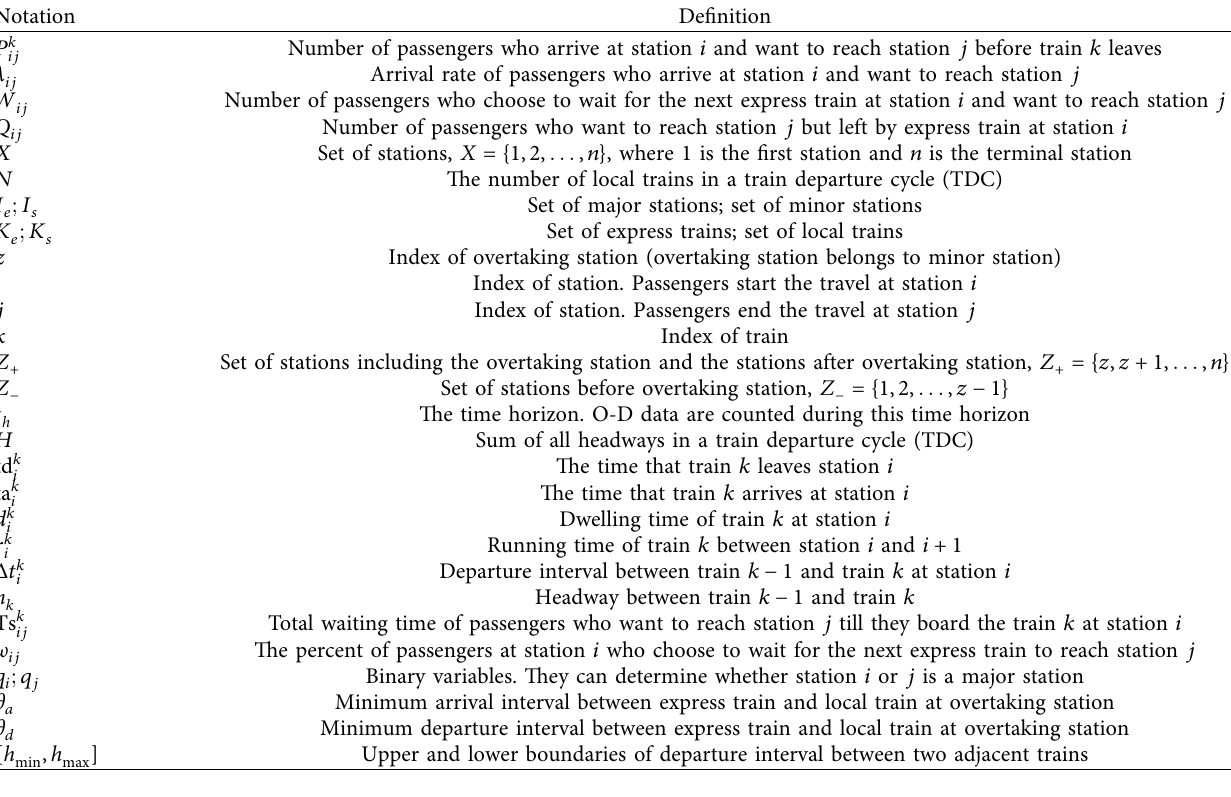
Table 1: List of parameters and variables.